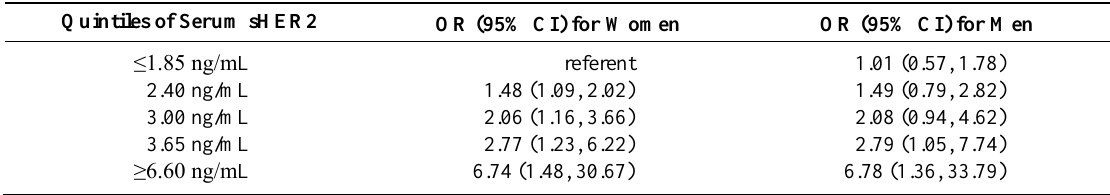
Table 3. Unadjusted relative risk of tumor histological subtype associated with serum sHER2 concentration. Unadjusted odds ratios (OR) and 95% confidence intervals (95% CI) comparing adenocarcinomas vs. squamous cell carcinomas are shown for quintiles of serum sHER2 concentration by